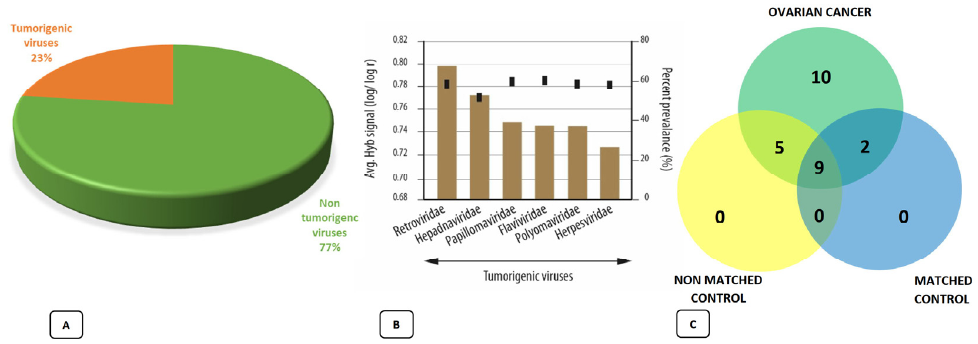
Figure 4. Viral signature found in ovarian tumor tissues: 23% of the discovered viruses were of the tumorigenic type and were found in more than 50% of the tumor samples ( A ). Major viral groups represented ( B ). The Venn diagram highlights how most of the viral findings are exclusively relevant to pathological tissues ( C ) [22].